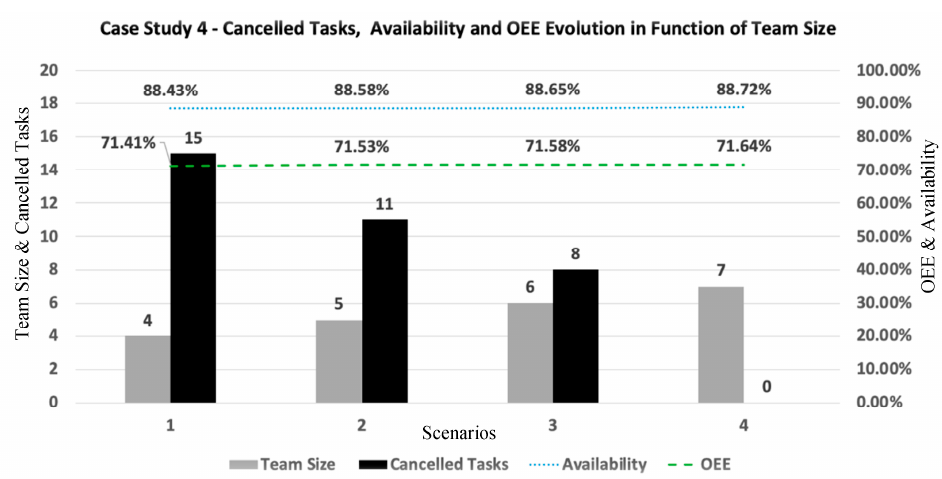
Figure 3. Case Study 4—Cancelled tasks, availability, and OEE evolution in team size function.